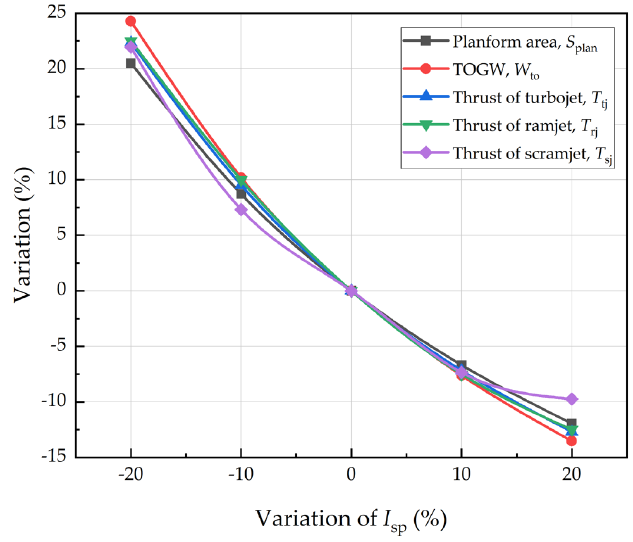
Figure 12. Impacts of specific impulse on the weight, size, and thrust.